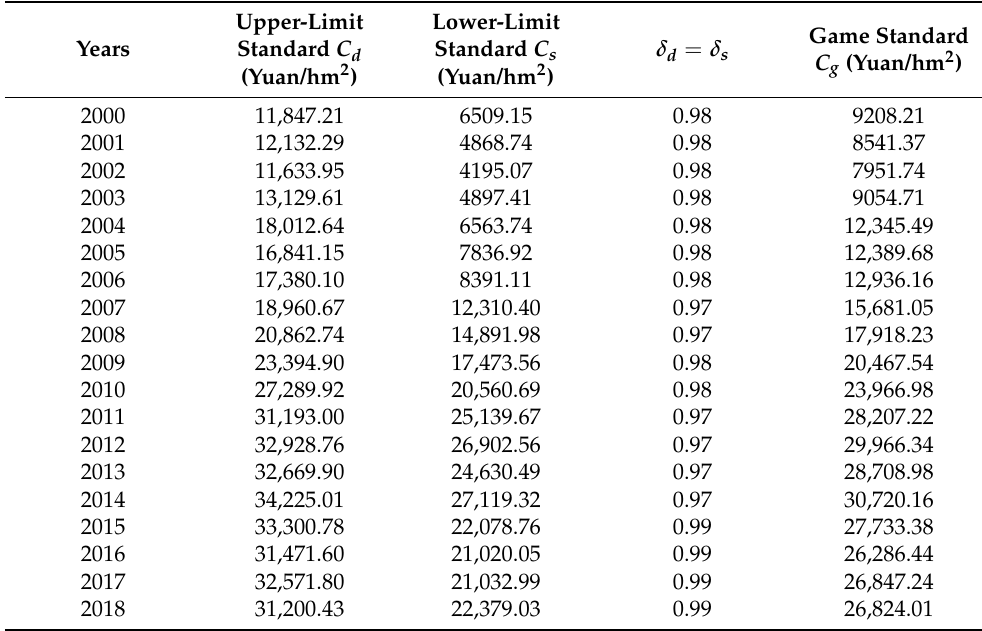
Table 4. Game standard of ecological compensation of cultivated land per unit in cultivated land ecological deficit area and surplus area of the Yangtze River Economic Belt from 2000 to 2018. Upper-Limit Lower-Limit Game Standard Years Standard C d Standard C s δ d = δ s C g (Yuan/hm 2 ) (Yuan/hm 2 ) (Yuan/hm 2 ) 2000 11,847.21 6509.15 0.98